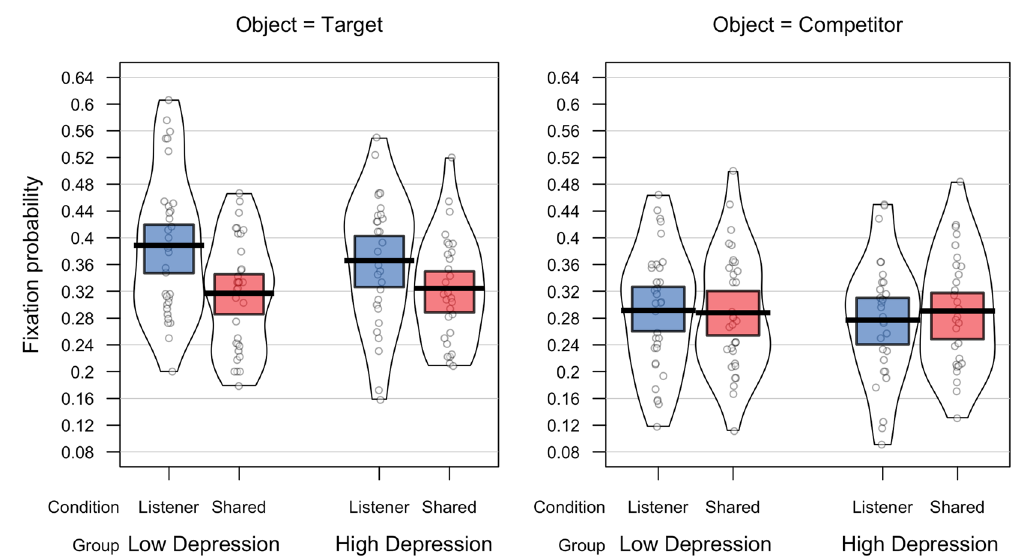
Figure 3. Probability of fixating the competitor object and the target object for each condition and depression